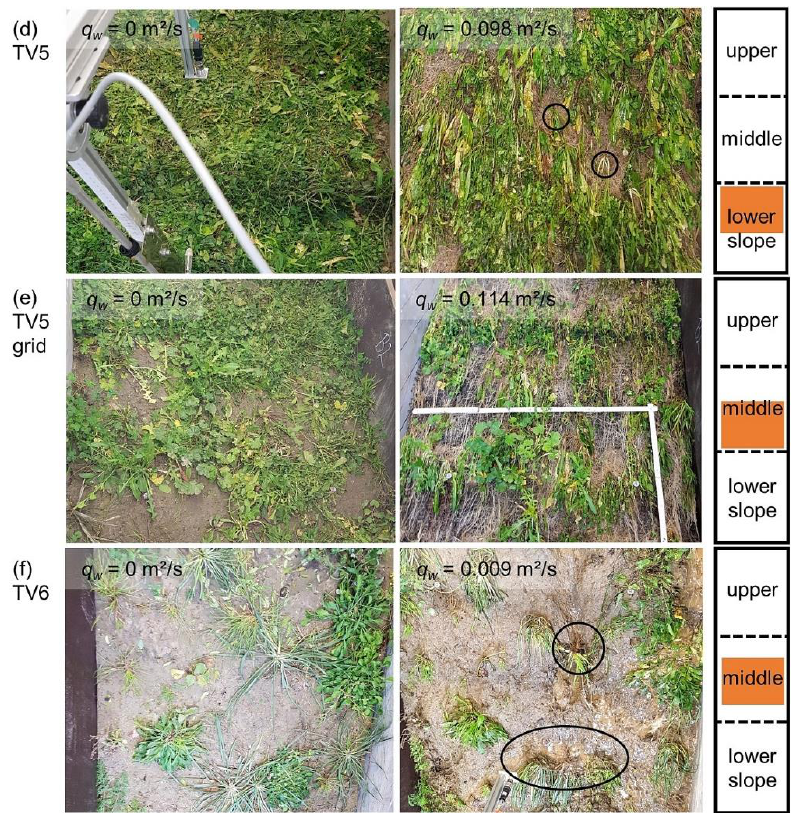
Figure 9. Erosion patterns during the overflow simulations: Sections of the test surfaces of TV1 ( a ), TV4 ( b ), TV4grid ( c ), TV5 ( d ), TV5grid ( e ), and TV6 ( f ) before (left) and after testing (middle). Positions of the sections along the slope (right). TV1 = species-poor grass-dominated mixture, TV4 = grass-herb mixture, TV5 = species-rich herb-dominated EcoDike mixture, TV6 = species-rich herb-dominated ready-mix, and grid = geogrid reinforcement.